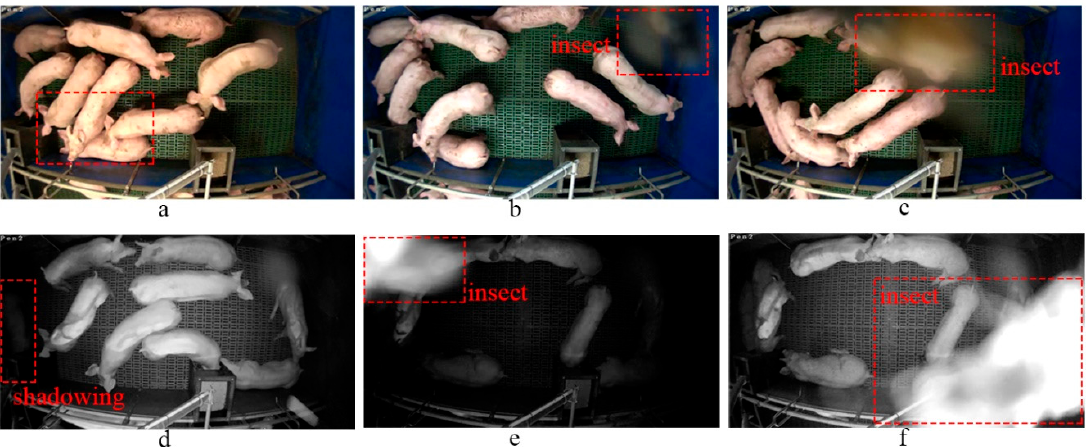
Figure 1. Challenges of automatic detection and tracking for individual pigs in real-world scenarios on a commercial farm. ( a ) Occlusions by pigs in day time (light-on) video footages; ( b ) insect causes the changes in illuminations from frame a to b in day time footages; ( c ) occlusions by insect in light-on footage; ( d ) shadows in the light-off video footage under IR model. ( e ) The insect effects on light-off footage; ( f ) the occlusion by insect in light-off footage.